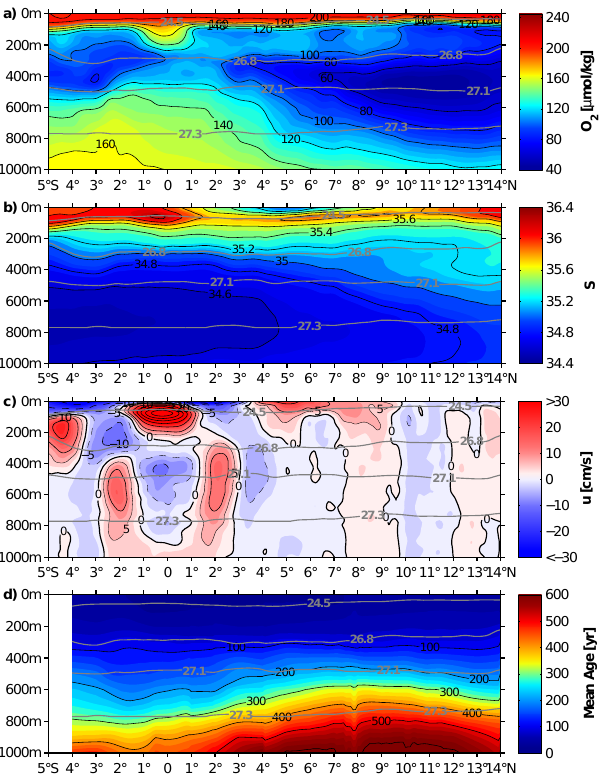
Figure 6. (a) Mean oxygen content, (b) salinity, (c) zonal velocity (positive eastward), and (d) mean age as obtained from meridional ship sections taken along 23 ◦ W during 1999–2012. Grey contours mark potential density (kgm − 3 ). Eastward current bands, marked by reddish colours, are generally associated with elevated oxygen content.